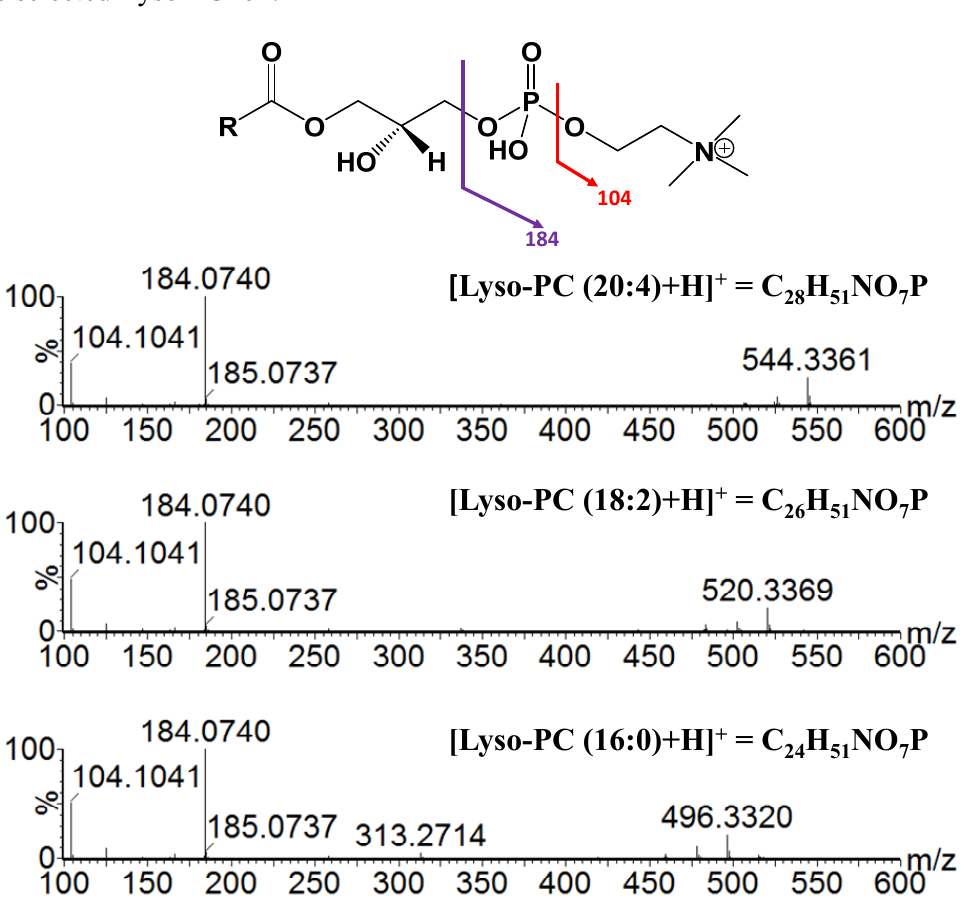
Figure 4. MS/MS spectra extracted from the high energy ion mobility spectrometry (IMS) function corresponding to drift time region 2 (~7.0 ms), which contains different Lyso-PCs. The general structure and the predicted fragmentation positions are given at the top. Both saturated and unsaturated ions give rise to the same characteristic fragment ion in high energy mode. The top right corner of each spectrum contains the molecular formula for the selected Lyso-PC